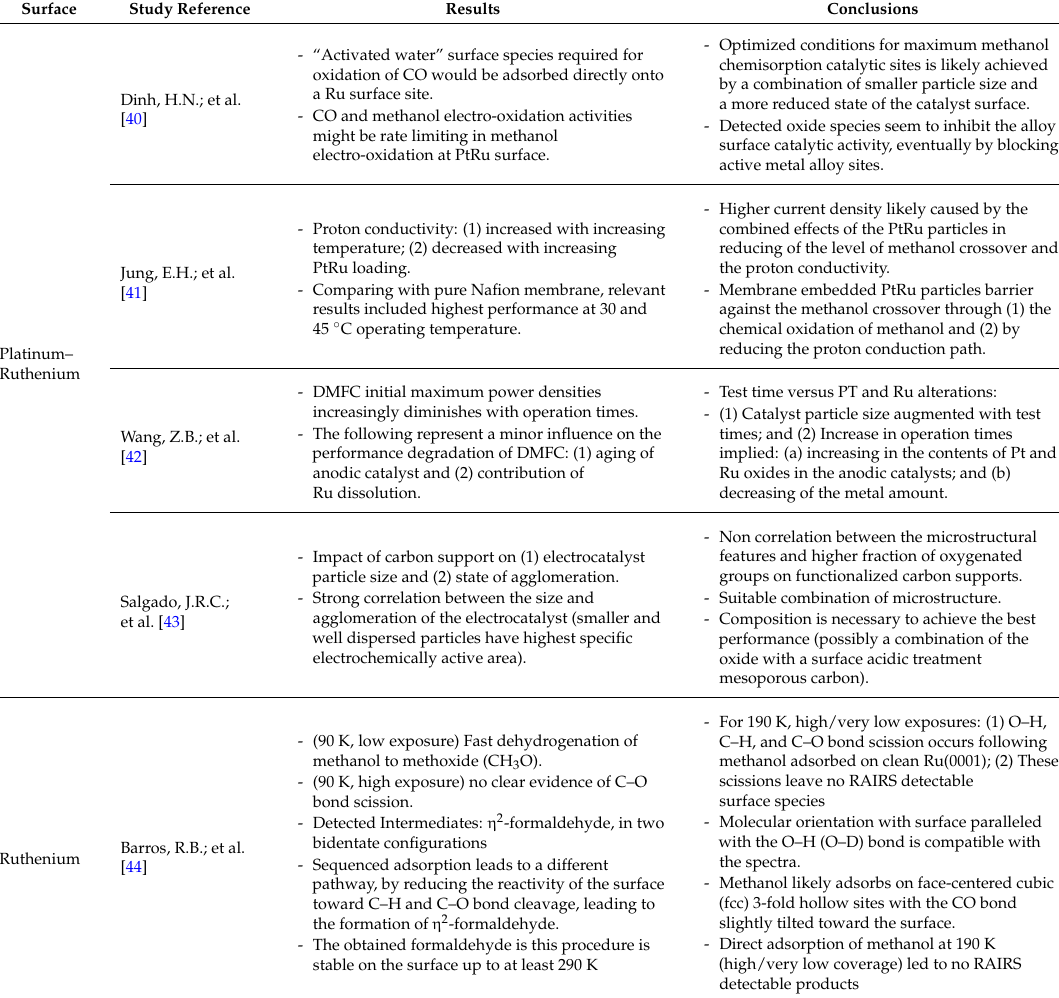
Table 2. Selected Experimental Data per catalyst and study reference, on chronological